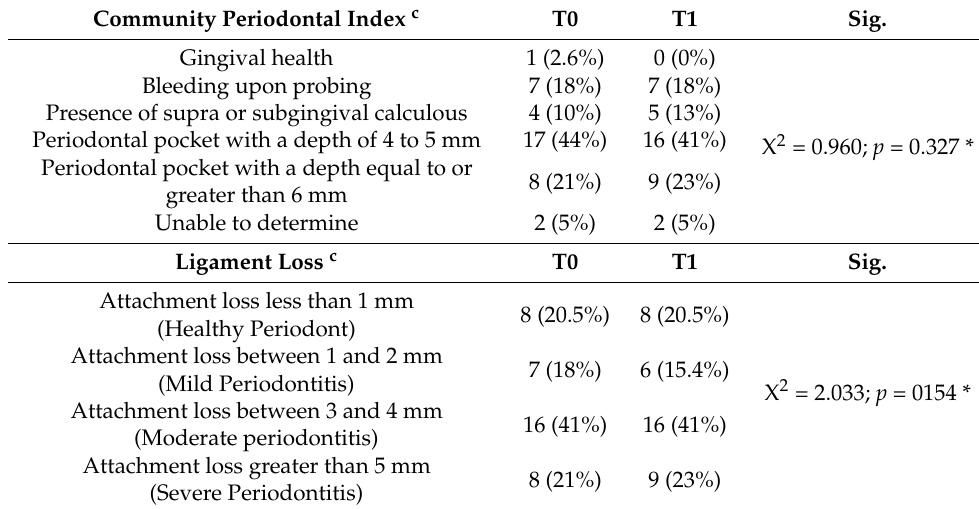
Table 7. Descriptive and comparative analysis of Periodontal Index and Ligament Loss, between assessment moments. Community Periodontal Index c T0 T1 Sig. Gingival health 1 (2.6%) 0 (0%) *Bleeding upon probing 7 (18%) 7 (18%) Presence of supra or subgingival calculous 4 (10%) 5 (13%) Periodontal pocket with a depth of 4 to 5 mm 17 (44%) 16 (41%) X 2 = 0.960; p = 0.327 Periodontal pocket with a depth equal to or 8 (21%) 9 (23%) greater than 6 mm Unable to determine 2 (5%) 2 (5%) Ligament Loss c T0 T1 Sig. Attachment loss less than 1 mm 8 (20.5%) 8 (20.5%) (Healthy Periodont) *Attachment loss between 1 and 2 mm 7 (18%) 6 (15.4%) (Mild Periodontitis) X 2 = 2.033; p = 0154 Attachment loss between 3 and 4 mm 16 (41%) 16 (41%) (Moderate periodontitis) Attachment loss greater than 5 mm 8 (Severe Periodontitis)